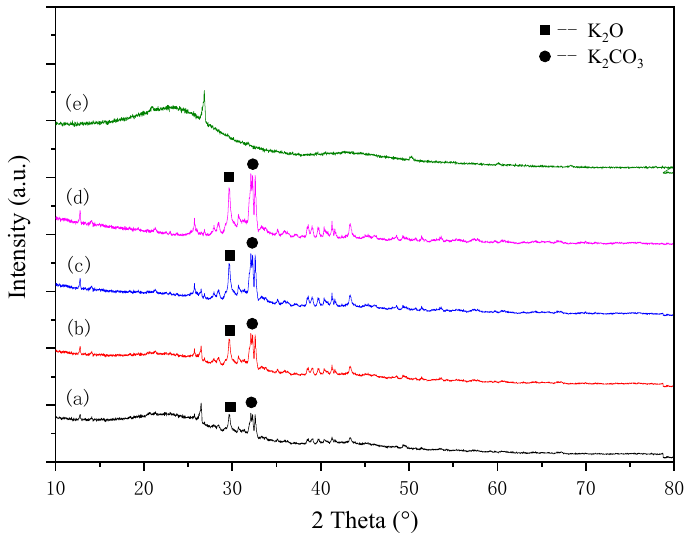
Figure 1. The XRD spectrum of the catalyst samples: (a) DN-250, (b) DN-300, (c) DN-350, (d) DN-400, and (e) PDN-350.